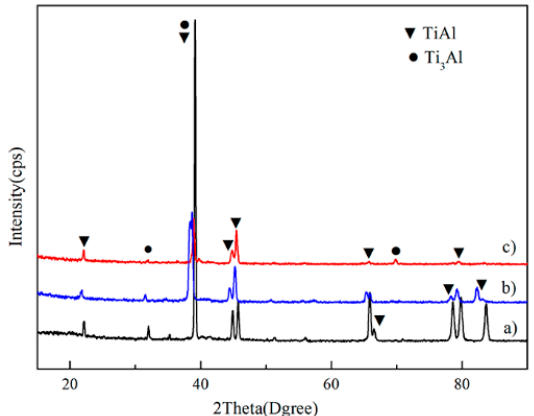
Figure 2. XRD patterns of the Ti-48Al-2Cr alloy solidified under different pressures. (a) ambient pressure, 1873 K; (b) 5 GPa, 1873 K; (c) 5 GPa, 1973 K.